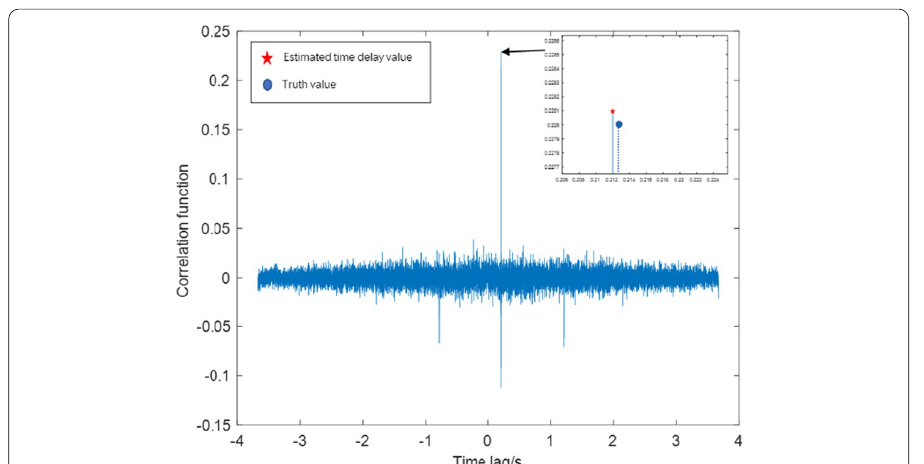
Fig. 11 PHAT pre-filter method (SNR